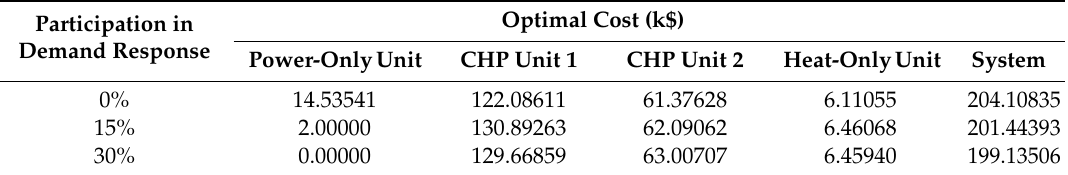
Table 12. The units’ cost for di ff erent participation percent in demand response for a typical day in week